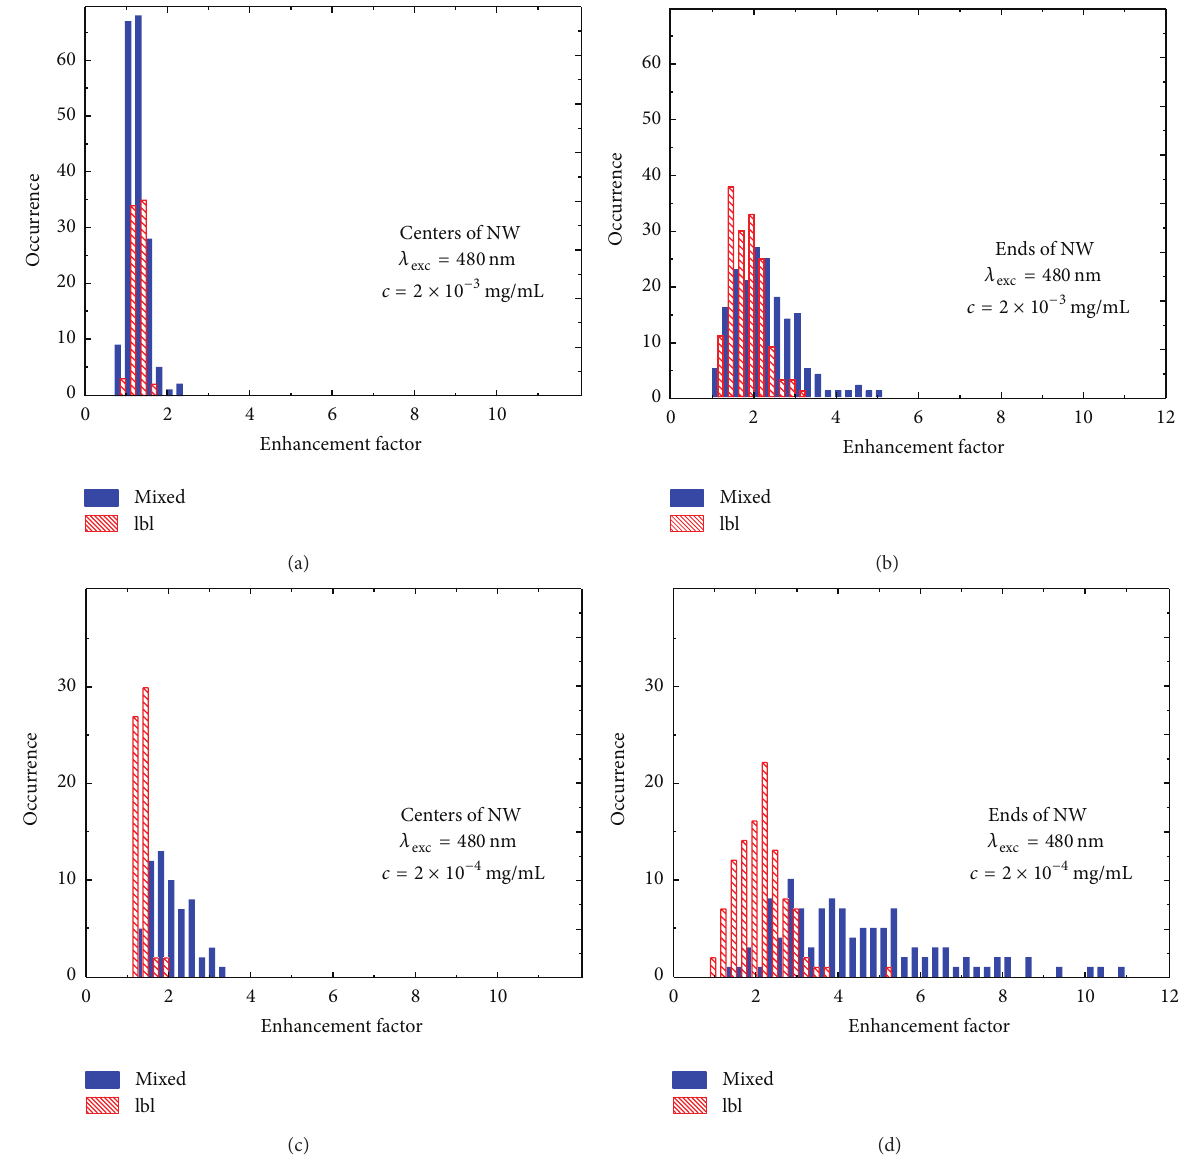
Figure 6: Histograms of the enhancement factors determined for the mixed (solid bars) and layer-by-layer (dashed bars) samples with the PCP complexes excited at 480nm. Data shown in (a) and (b) correspond to the PCP concentration of 2 × 10 −3 mg/mL and for the central parts of NW and for the ends of NW, respectively. Data shown in (c) and (d) correspond to the PCP concentration of 1×10 −4 mg/mL and for the central parts of NW and for the ends of NW,